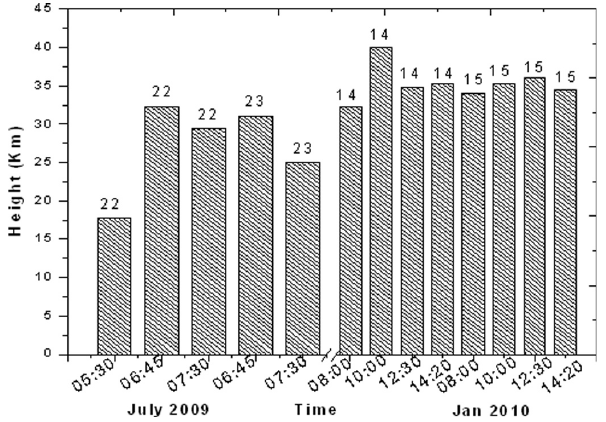
Fig. 1. Details of the balloon launch timings and its height coverage during partial solar eclipse of July 2009 and annular solar eclipse January